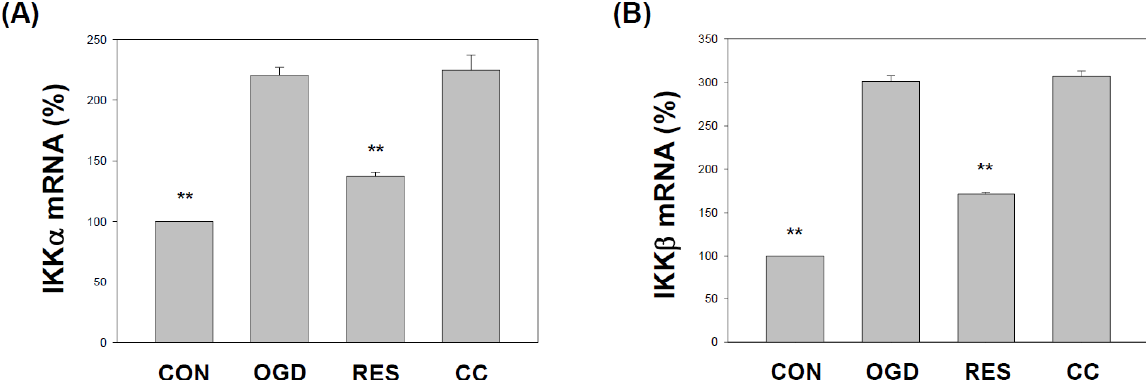
Figure 2. Resveratrol rescues IKK α and IKK β mRNA expression in OGD-induced cells within a 3D scaffold. The cell experiments under the scaffolds were divided into four groups, as described in Figure 1 and the methods section. Use qPCR to analyze IKKα ( A ) and IKK β ( B ) mRNA transcripts. Collect total RNA from SH-SY5Y cells and reverse transcribe it into cDNA. Next, perform qPCR on the specified gene and normalize it to GAPDH expression. The value is expressed as a percentage of the transcript established in CON and described as the mean ± SEM value from three independent experiments. Specific comparison to the indicated SH-SY5Y cells with OGD ** p < 0.001 vs. cells with OGD.